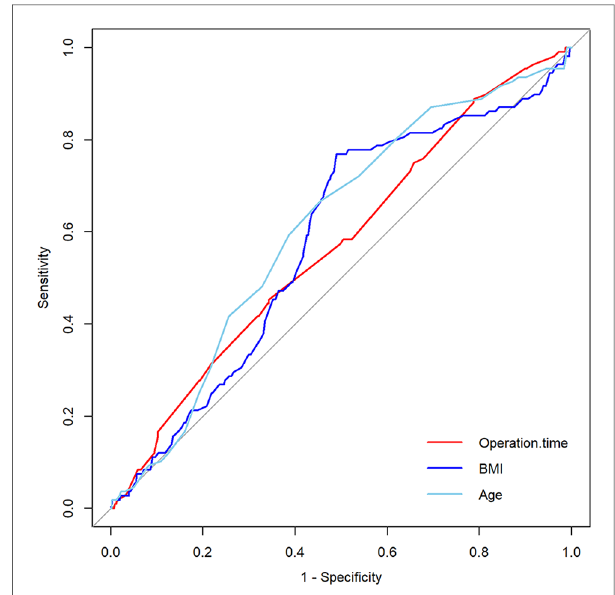
FIGURE 1 The ROC curve of continuous variables was investigated by using univariate analysis.